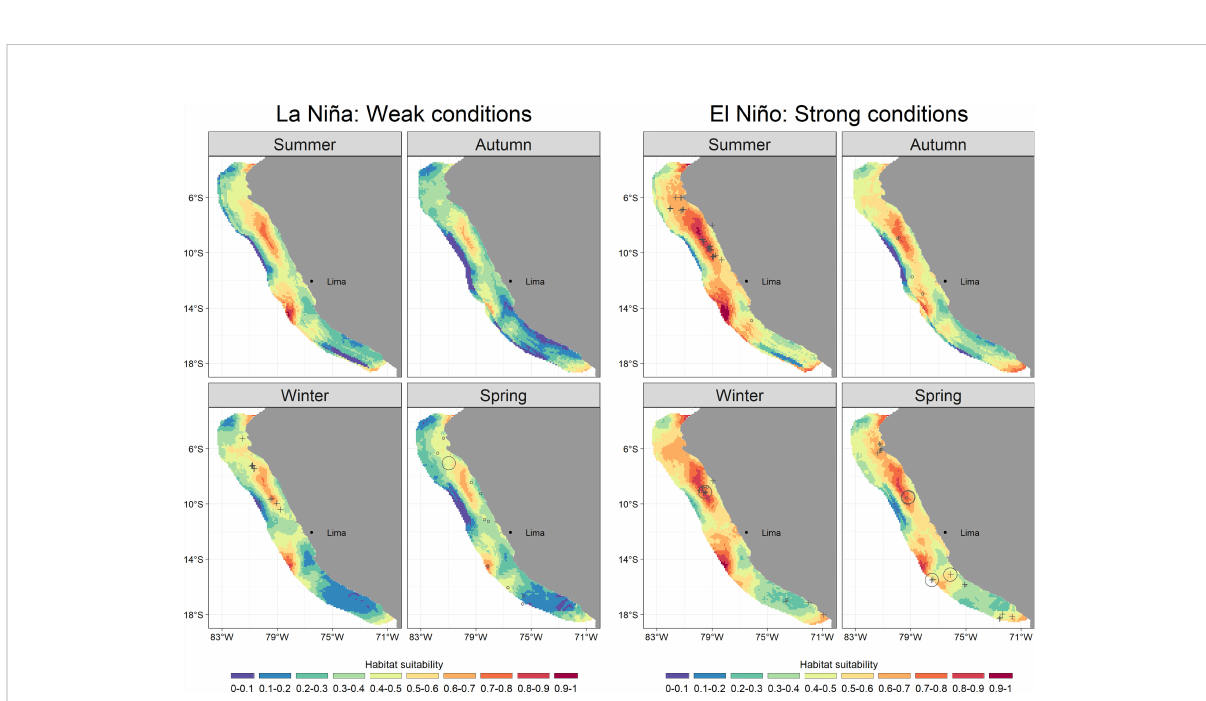
FIGURE 6 Predicted values of bottlenose dolphin ( Tursiops truncatus ) habitat suitability for the geographical space during La Niña and El Niño conditions. Empty circle size represents the observed group counts in each sample unit (i.e., transect). Crosses represent validation data, not included as data in the model.